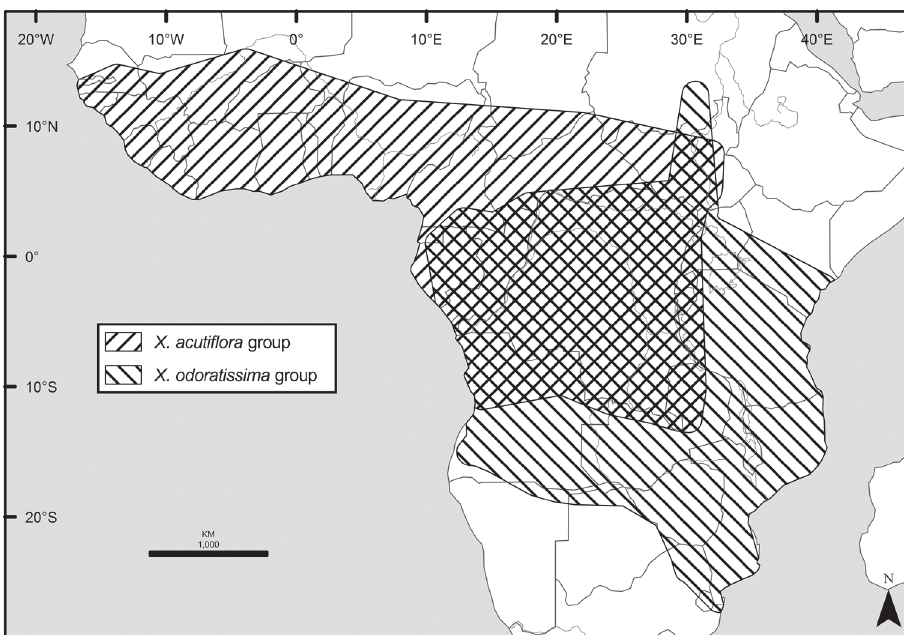
Figure 8. Aggregate distributions of the Xylopia acutiflora and X. odoratissima groups of section Stenoxy- lopia in Africa. Bolder lines represent country borders, fainter lines lakes and major